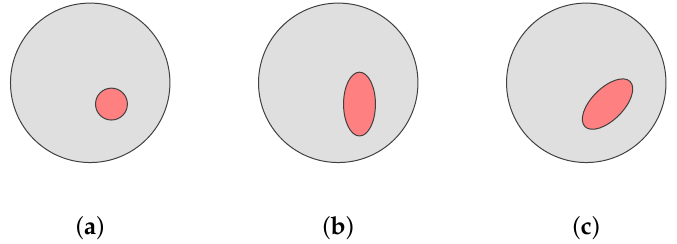
Figure 2. An example of the random transformation used in dataset generation, applied to a circular shape. ( a ) Circle with offset. ( b ) Circle with offset and scaling. ( c ) Circle with offset, scaling and